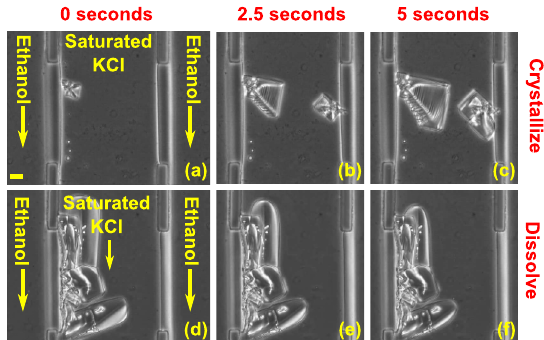
FIG. 3. Antisolvent diffuses from the reservoir channels across HMMs into a saturated aqueous salt solution in the sample channel, depicted in the three-channel device of Figs. 1(b) and 1(c). (a-c) Upon stopping KCl flow in the sample channel, ethanol diffusesthrough the HMMs. Asethanol concentration progressively increases near the HMM, KCl solubility decreases, triggering nu- cleation and growth of KCl crystals. (d-f) Resuming convective delivery of fresh aqueous KCl solution flushes away the ethanol, restoring KCl solubility toits bulkaqueous value,and dissolving the crystals. (SeeVideos 2 and 3.)(Phasecontrast,scale bar ¼ 20 (cid:1) m